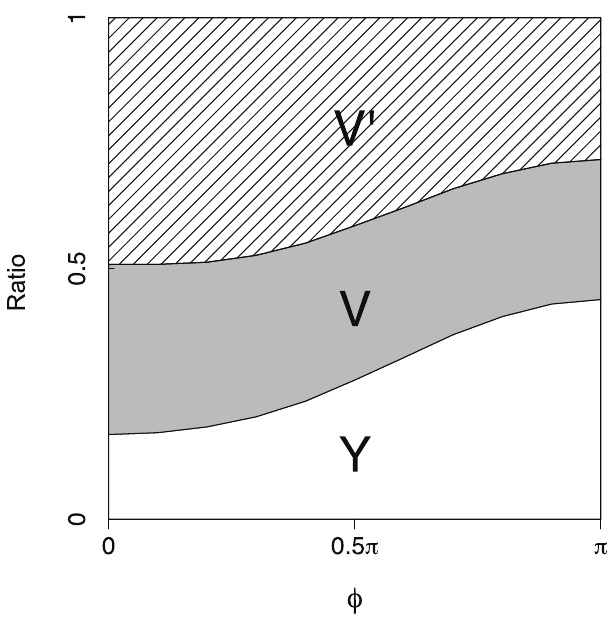
Figure 9. Observation ratio for small network. The network in Fig. 7 was used. Y, V, and V 9 respectively denote the network topologies represented in Figs. 8 G , 8 H , and 8 I–J . The parameter m ~ 2 : 0 was set. In each calculation against , all combinations among D i ~ 0 : 1,0 : 2, (cid:2)(cid:2)(cid:2) ,1 : 0 for all links i ~ 1,2, (cid:2)(cid:2)(cid:2) ,5 (specifically, a total of 10 5 combinations) were tested as initial conditions. The networks such as the ones shown in Fig. 8 K and L were also observed but the observation ratios were extremely small, e.g., 0 when 0 ƒ ƒ 0 : 7 p , 0.002 when ~ 0 : 8 p , 0.018 when ~ 0 : 9 p , and 0.03 when ~ p . doi:10.1371/journal.pone.0089231.g009 ~ 0 : 5(1 z sin v t ), The equation (6) is redefined as I out 1 ~ 0 : 5 f 1 z sin( v t z ) g , where the magnitude of the input/ I out 2 output flux is set as half of those in Eq. (6) because the network size is now reduced.